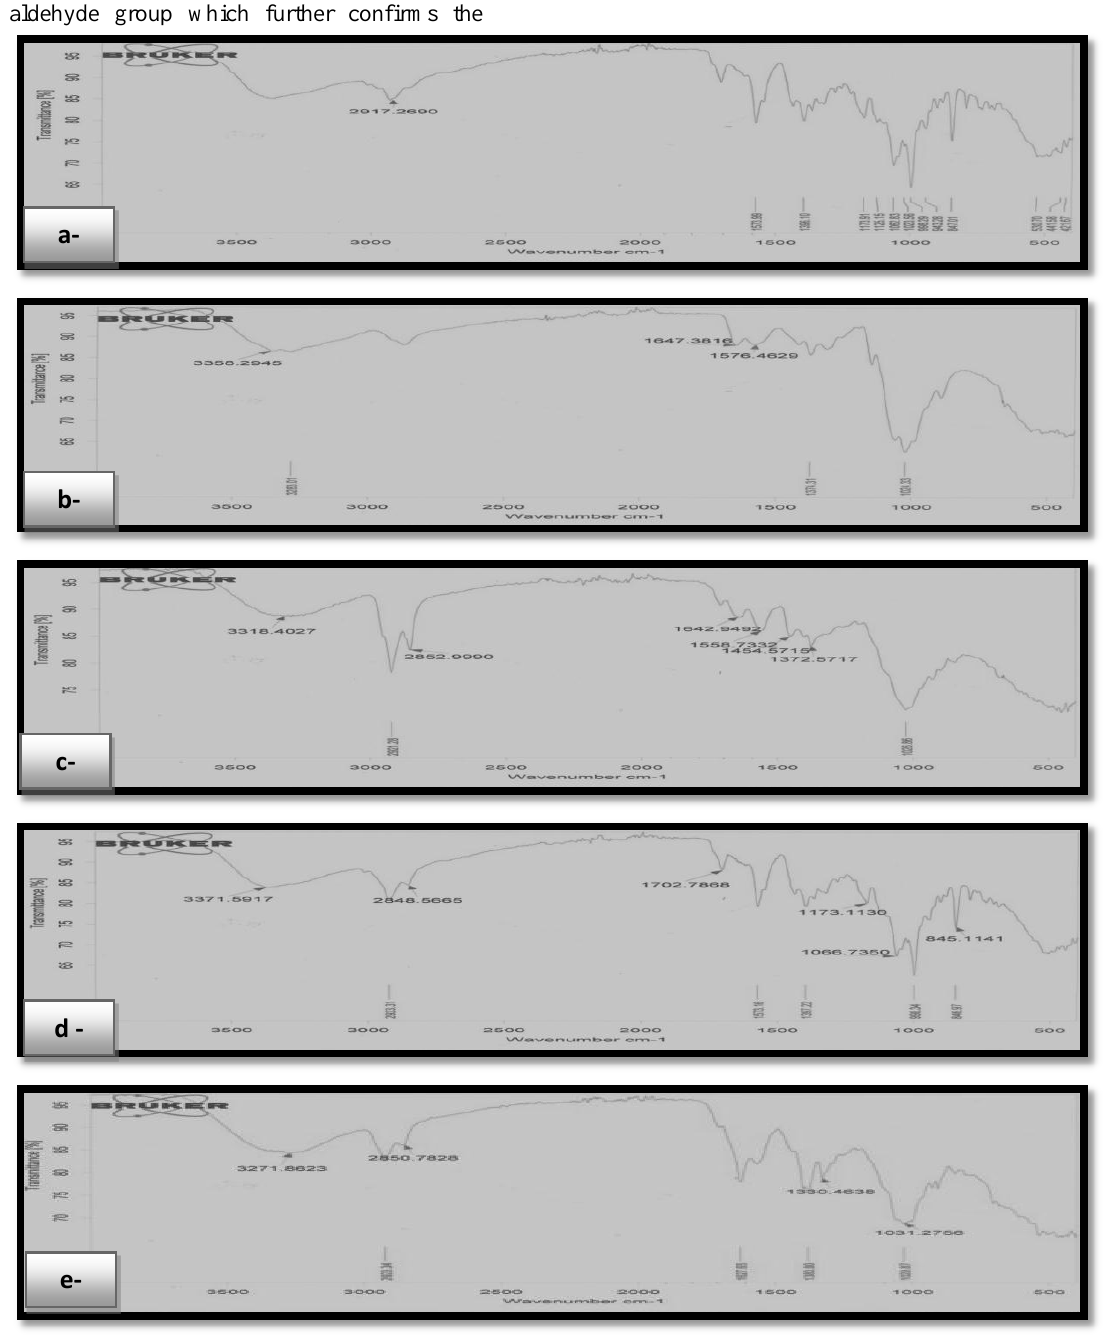
Figure( 3): FTIR spectra of pure nystatin (a), chitosan (b), blank chitosan microparticles (c), physical mixture of nystatin and blank microparticles (d) and nystatin loaded microparticles